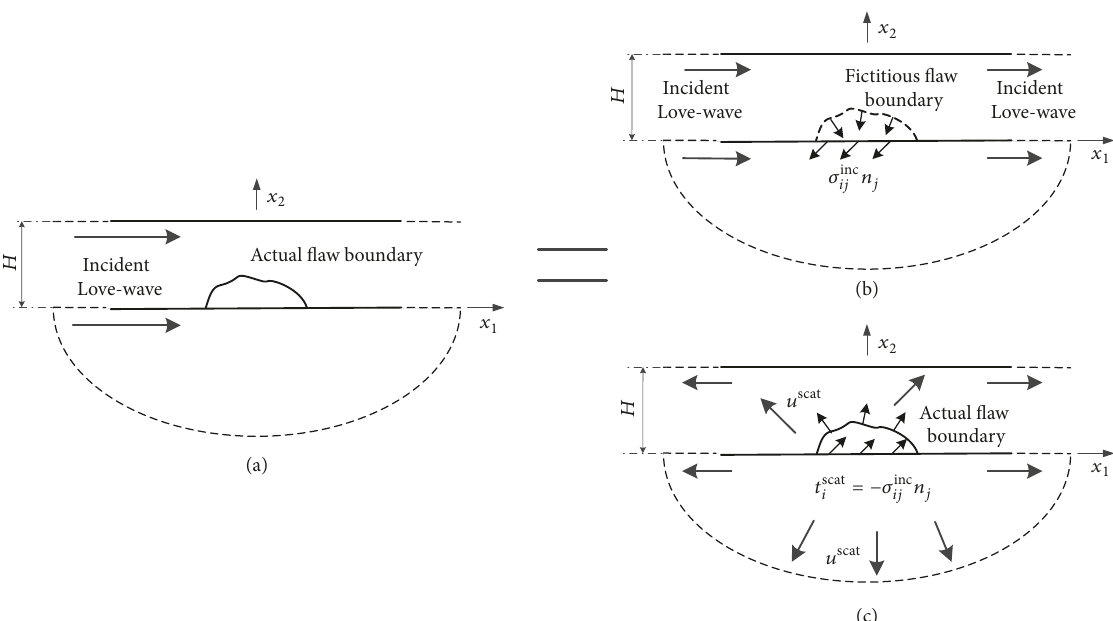
Figure 1: Linear superposition principle: (a) the total field; (b) the incident field; (c) the scattered